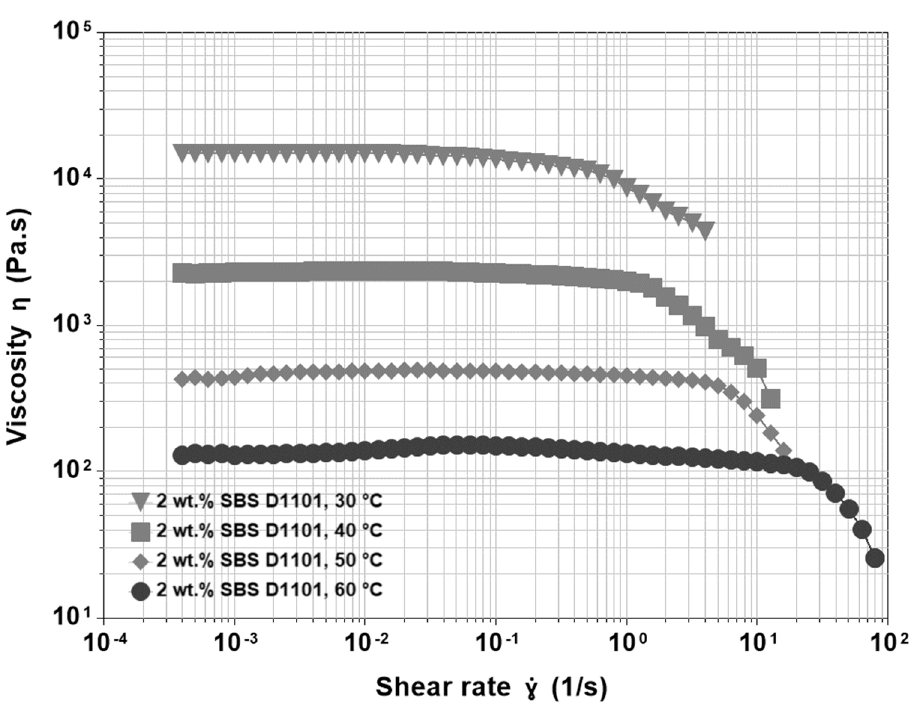
Figure 3. Viscosity functions at different temperatures for 200/300 Pen grade modified by 2 wt.% SBS D1101.